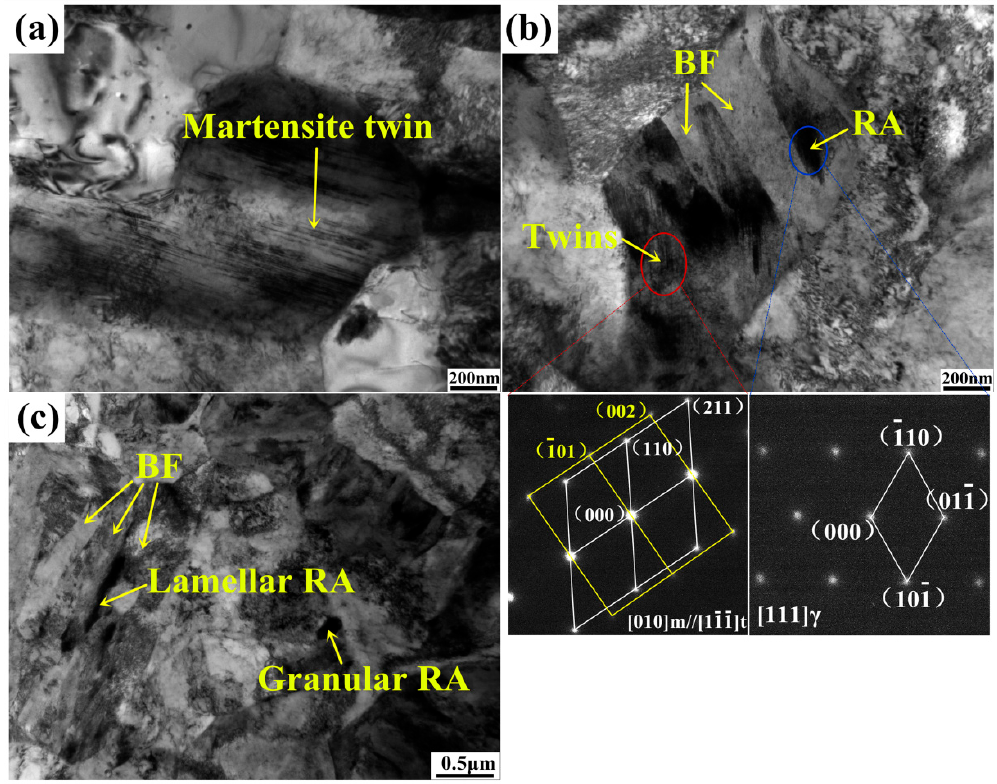
Figure 4. TEM micrographs showing RA and martensite morphology after deformation: ( a ) blocky-type RA transformation to martensite twin at 15% strain; ( b ) film-like RA transformation to martensite twin at 15% strain; ( c ) untransformed RA between bainitc ferrite plates and in ferrite grains observed in fractured tensile specimen.